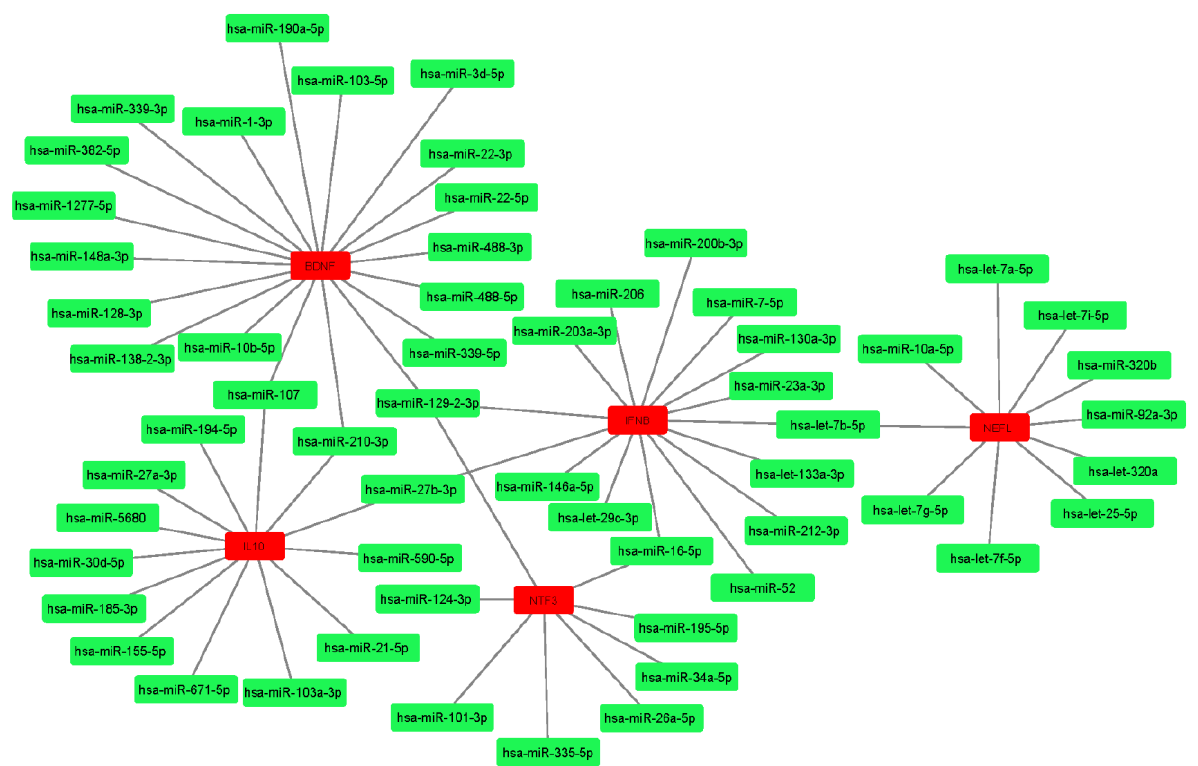
Figure 3. Top five ranked gene nodes and their interactions from gene – miRNA network.